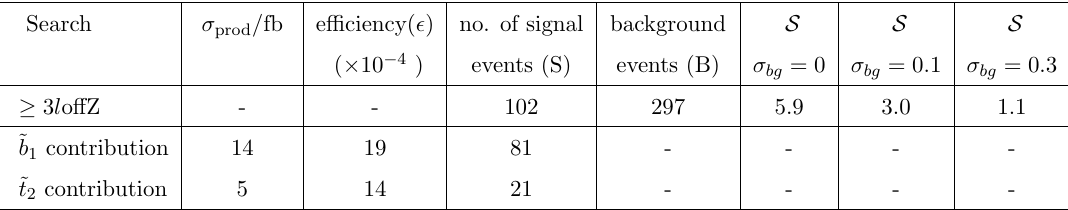
q B + (cid:27) 2 B 2 . See text for bg